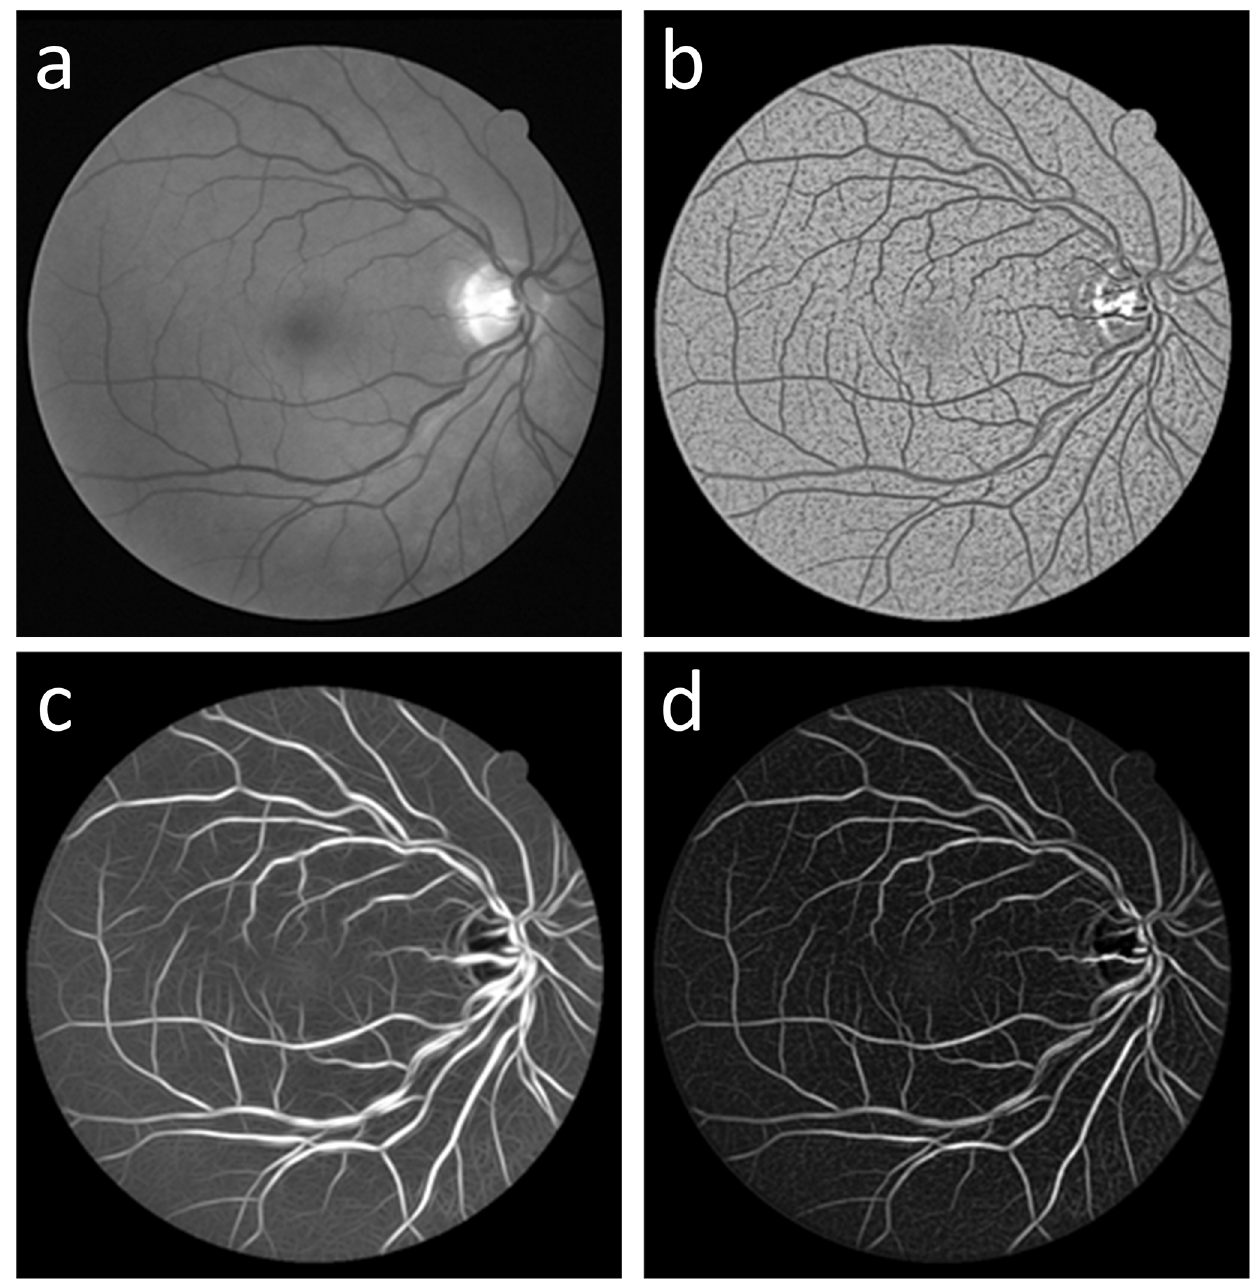
Fig 2. Comparisons of (a) the original green channel retinal image I green , (b) the result of the proposed gray-voting algorithm I vessel , (c) the result of the 2D-Gabor filter I Gabor , and (d) the fusing result I gv